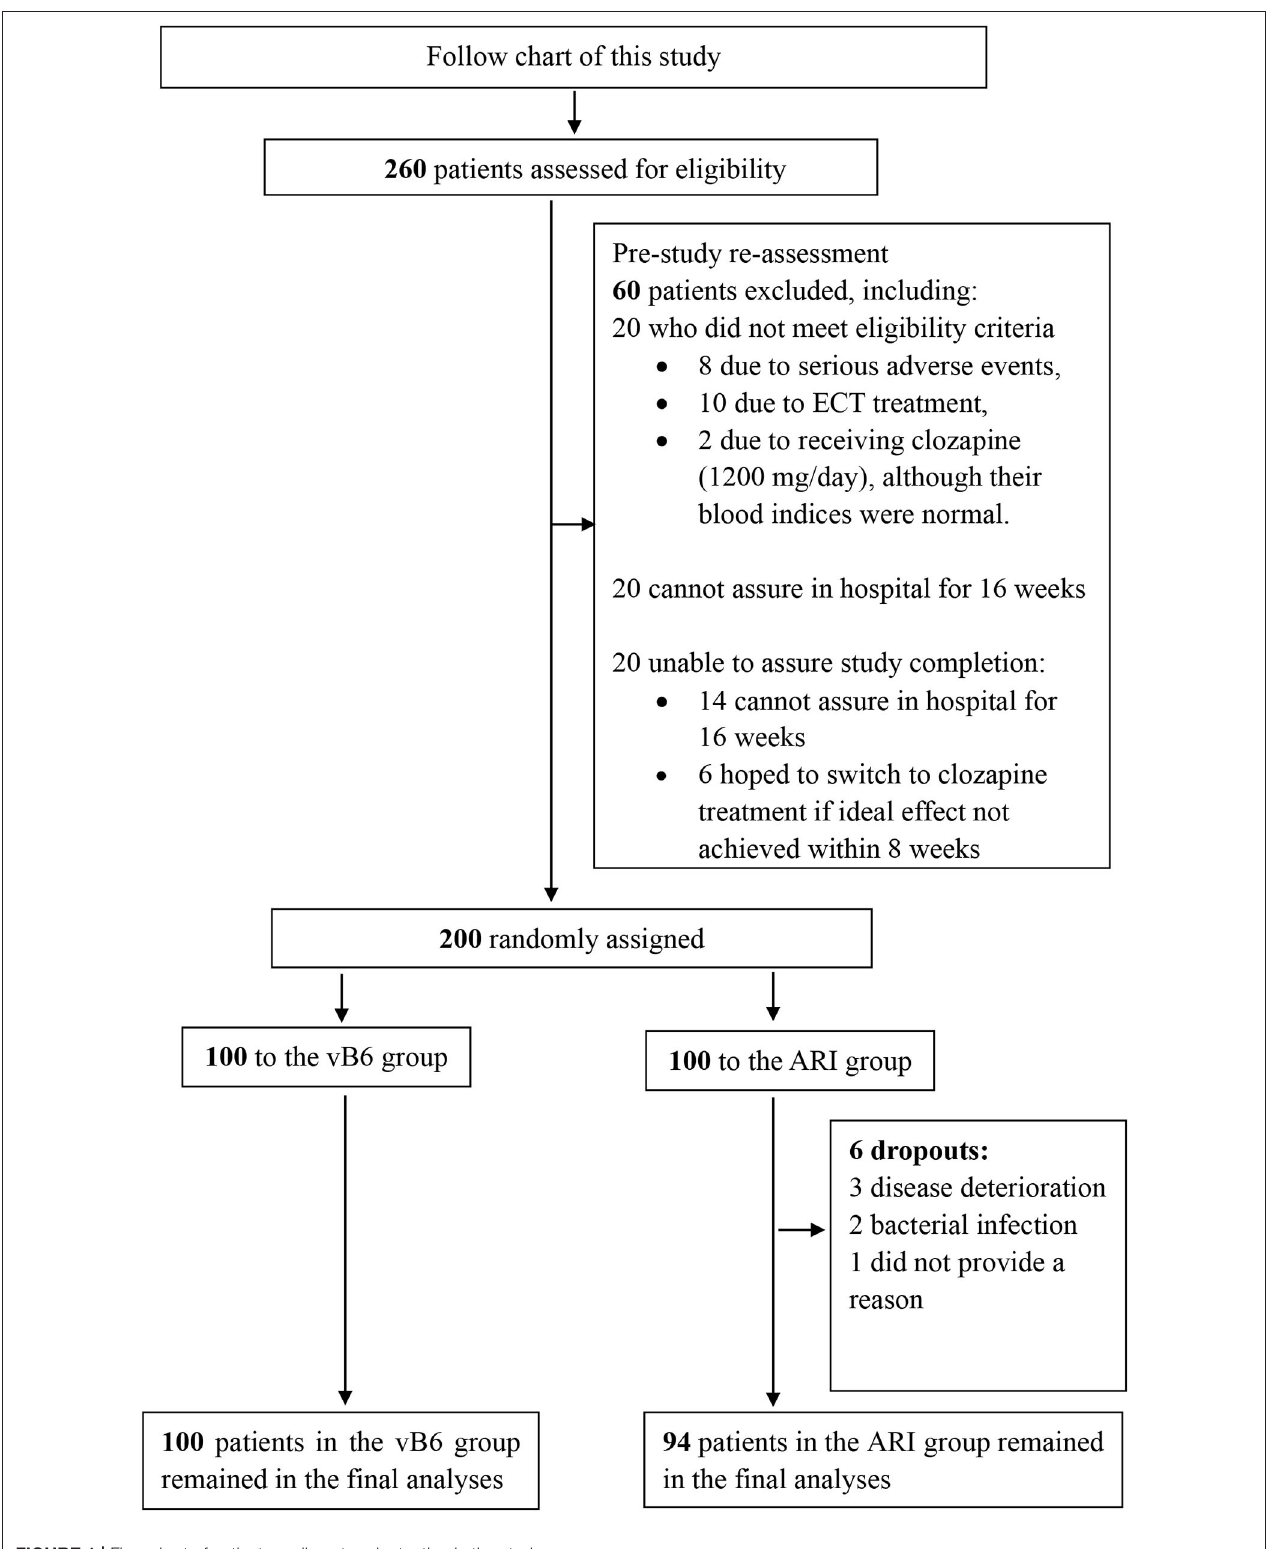
FIGURE 1 | Flow chart of patient enrollment and retention in the study.